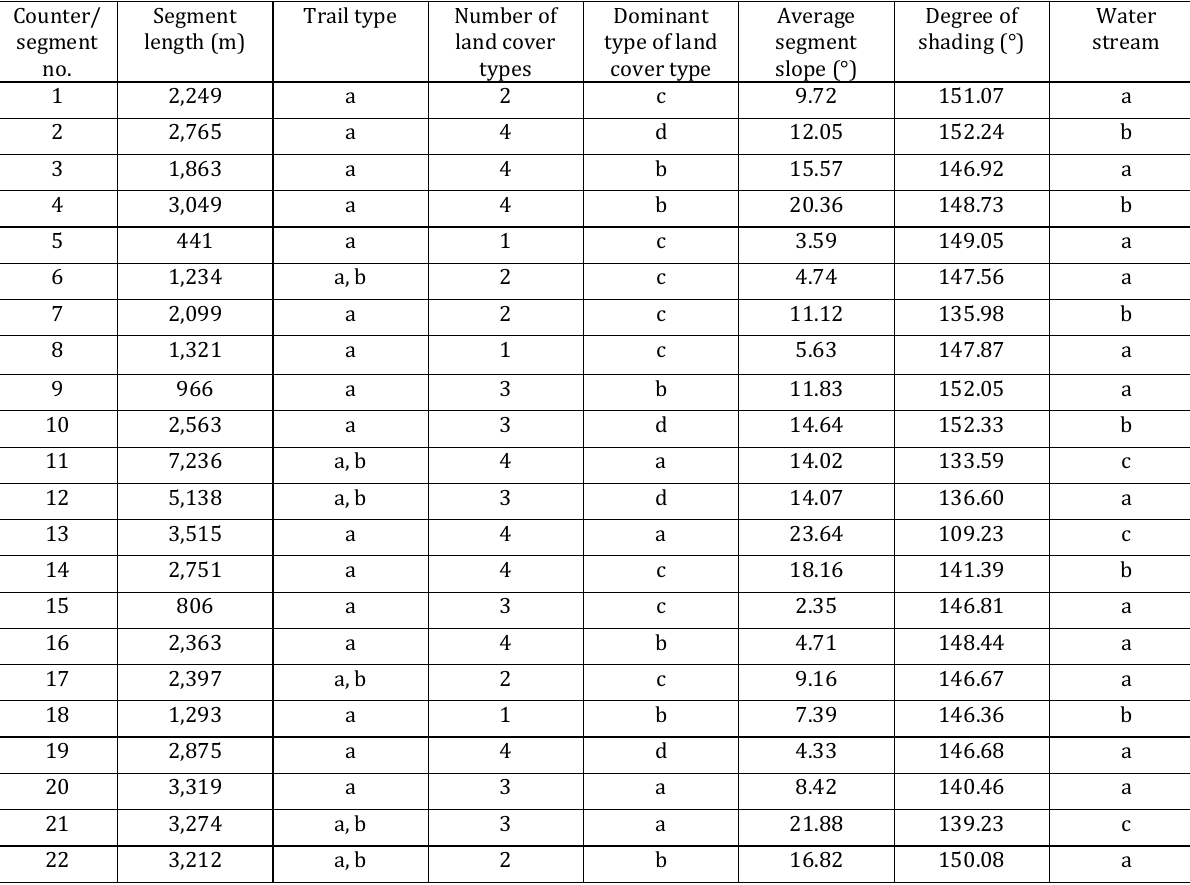
Fig. 4. Photographs from the study area depicting CORINE land cover types indicated along evaluated segments: coniferous forest (a), natural grassland (b), moors and heathland (c), transitional woodland – shrub (d) Table 2. Results of the GIS analyses of trail characteristics (codes and scoring are explained in Table